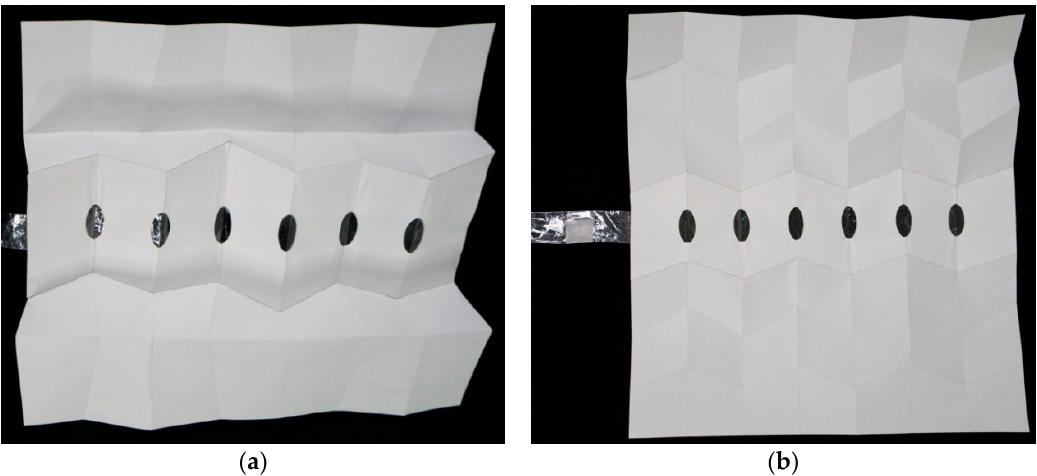
Figure 11. Models with the single vein implemented in the middle of the patterns. In this figure, the veins are not inflated. ( a ) Corresponds to the #105b folding pattern, while ( b ) refers to #206.